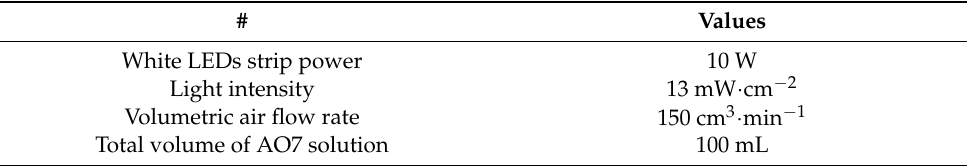
Table 1. Reaction